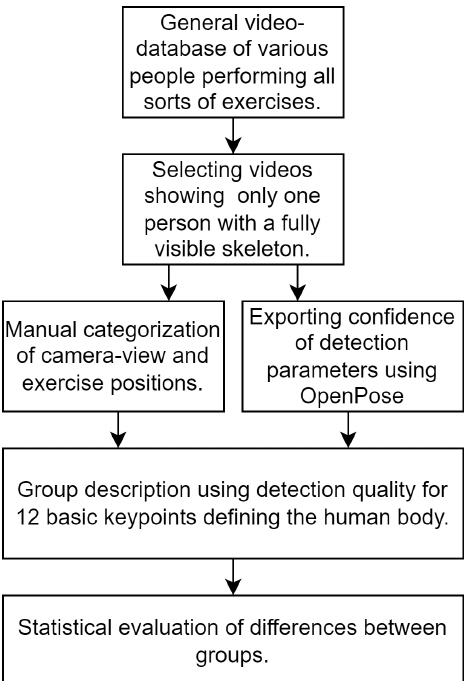
Figure 1. Study design—diagram explaining the sequence of